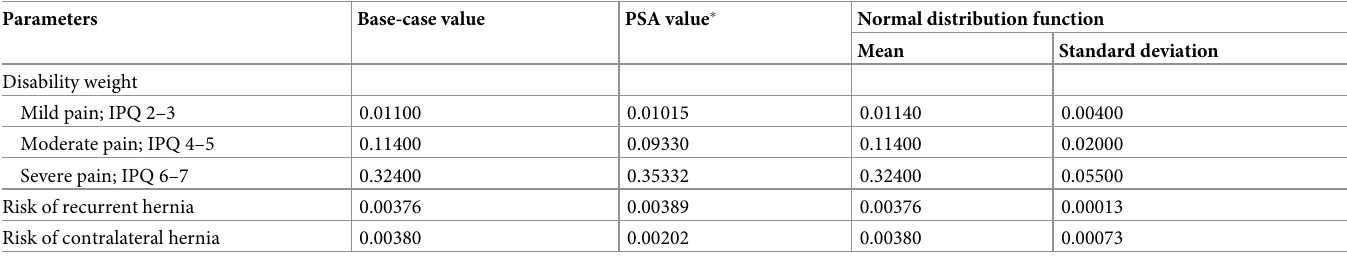
Table 5. Values used in probabilistic sensitivity